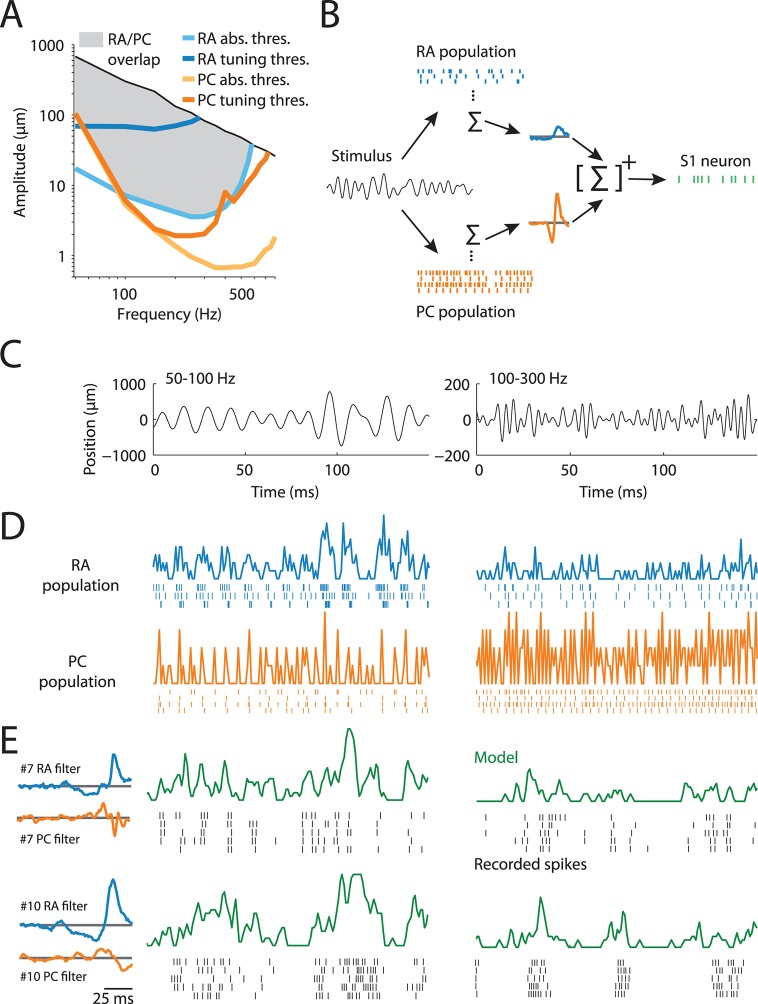
Characterizing the transformation between peripheral and cortical responses. (A) Frequency–amplitude pairs that elicit responses in rapidly adapting (RA) and Pacinian (PC) afferents. Light blue and orange lines indicate absolute response thresholds for RA and PC afferents (as determined by the peripheral model), respectively, while the dark blue and orange lines denote tuning thresholds (i.e., eliciting one spike on each stimulus cycle). The black line corresponds to the highest amplitude the stimulator could deliver at a given frequency and likely exceeds the maximum amplitude that one is liable to encounter during every day tactile experience. While RA and PC afferents are maximally sensitive at different frequencies, most frequency–amplitude pairs elicit responses from both afferent classes (indicated by the shaded region). (B) Illustration of the model that describes the transformation from peripheral to cortical responses. A broadband noise stimulus activates both RA and PC afferents. RA and PC population responses are each convolved with a temporal filter, then summed and rectified to culminate in the responses of individual S1 neurons. (C) Two examples of vibratory stimuli. (D) Simulated RA (blue) and PC (orange) population firing rates along with spike trains of a subset of neurons in the population. See Figure 1—figure supplement 1 for details on how the peripheral population models were validated. (E) Recorded spikes (black ticks) over five stimulus repeats and model predictions (green traces) for two cortical neurons, whose RA and PC filters (plotting filter magnitude over time) are shown on the left. Cortical neurons differ in their response properties, such as burstiness and temporal precision, and the model captures these broad differences with different RA and PC filters. See Figure 1—figure supplement 2 for assessment of the general predictive power of our model.